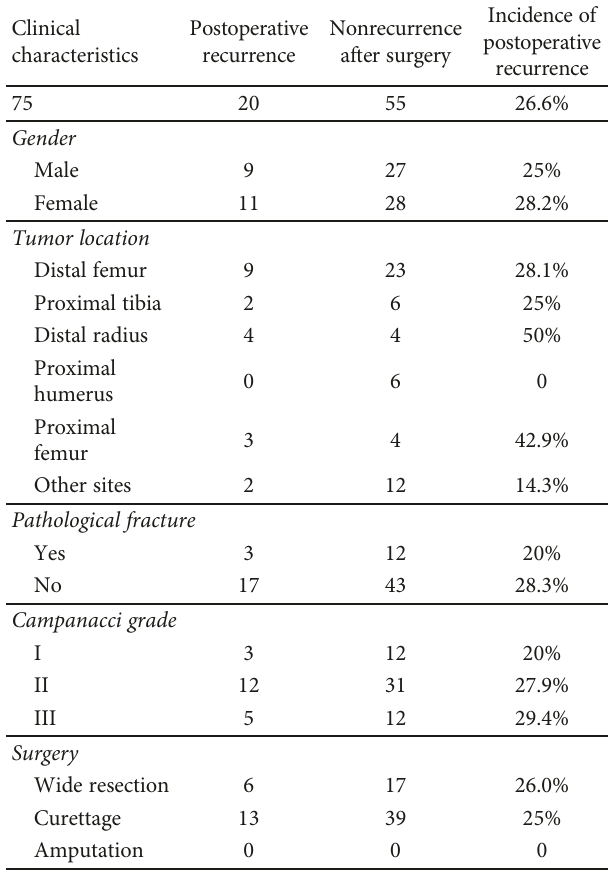
Table 1: Clinical characteristics of the 75 GCT cases included in the present